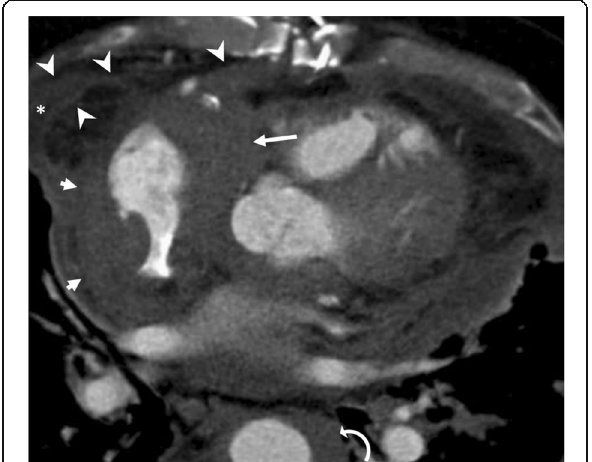
Fig. 9 A 61-year-old man with Erdheim-Chester disease. Axial reformatted contrast-enhanced CT image demonstrates lobulated soft tissue densities with pseudo-tumor appearance involving the right atrium (short arrows), right atrioventricular groove (long arrow), and the aortic wall (curved arrow). Pericardial (asterisk) effusion and thickening (arrowheads) are also